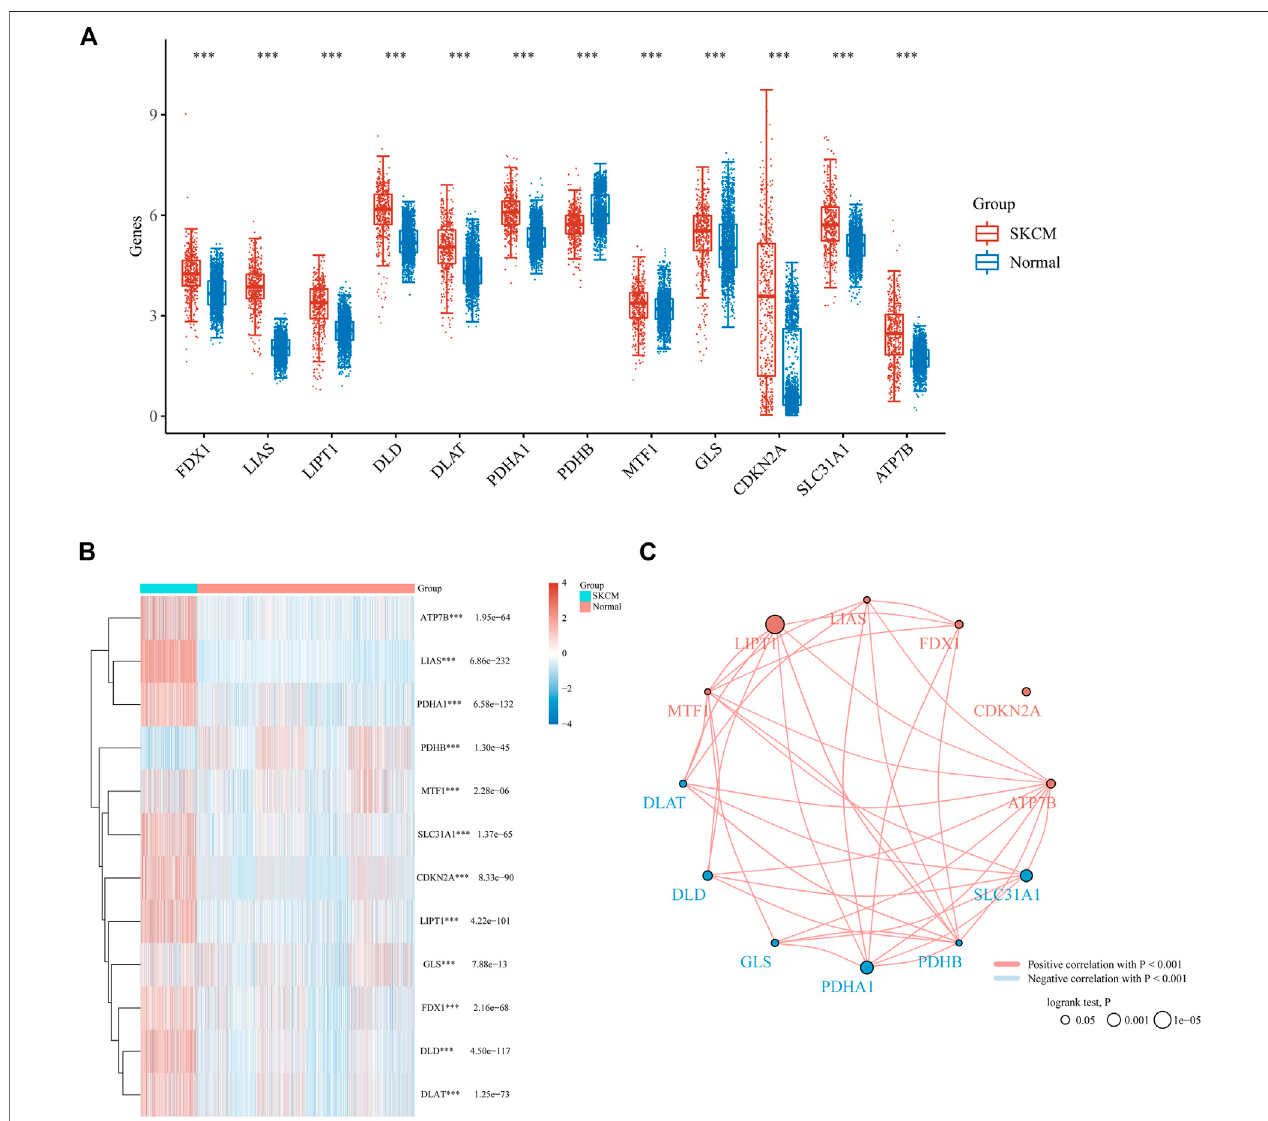
FIGURE 1 | Cuproptosis-related genes expressed in SKCM patients and their correlation and prognostic value. Box plots (A) and heat map (B) of cuproptosis- related genes in SKCM compared to normal tissues. (C) Spearman correlation and prognostic values of cuproptosis-related genes in SKCM. Red represents positive correlation whereas blue represents negative correlation. The larger the circle the smaller log-rank p . *** p < 0.001.